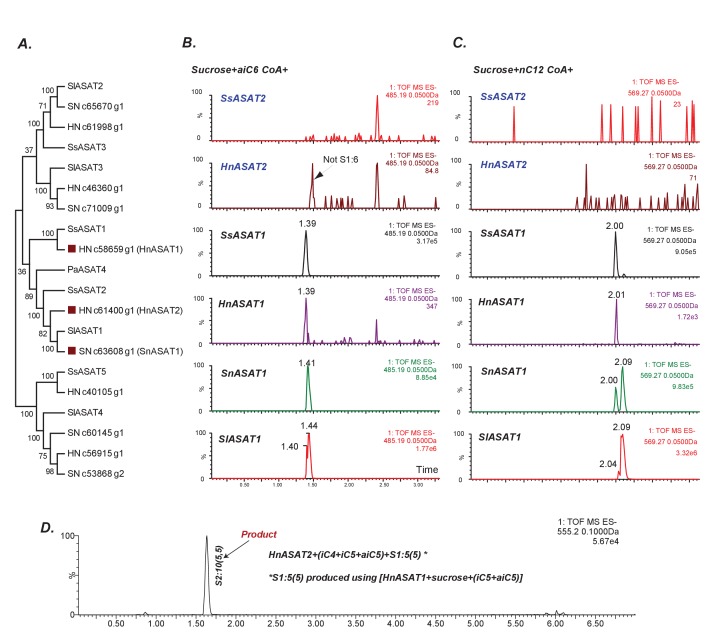
Some aASAT2 orthologs cannot catalyze sucrose to mono-acylsucrose conversion.(A) Neighbor-joining tree made using Salpiglossis and tomato ASATs and their best hits in S. nigrum (Sn) and H. niger (Hn) transcriptome database. Tree was made using default parameters in MEGA6 for alignment and phylogeny, and identifies putative aASAT2 orthologs in Sn and Hn. (B–D) LC/MS extracted ion chromatograms for S1:6(6) [B], S1:12(12) [C] and S2:10(5,5) [D]. All reactions were run on a C18 LC column. Results show that Hn, Ss, Sn and SlASAT1s can catalyze sucrose to mono-acylsucrose conversion using aiC6 and nC12 CoA. However, aASAT2 orthologs in Hn and Ss are not able to catalyze this reaction. (D) HnASAT2 is able to catalyze di-acylsucrose formation using the HnASAT1 product.